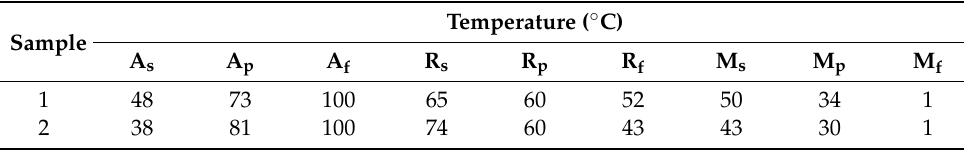
Table 2. Transformation temperatures for plasma sprayed samples 1 and